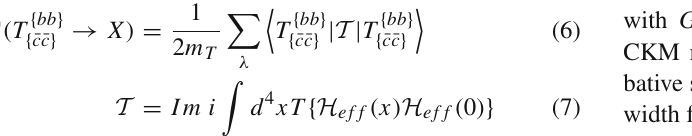
shown in d , e , and the singly bottom baryon multiplets are given in f , g signed as F b ¯ 6